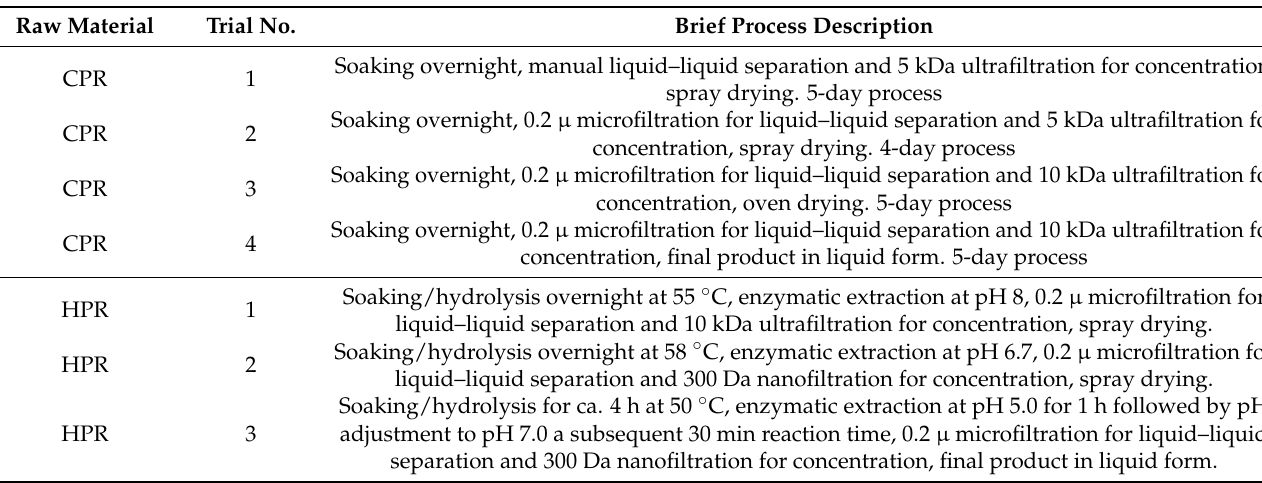
Table 4. The description of different processing parameters that were tested. Raw Material Trial No.